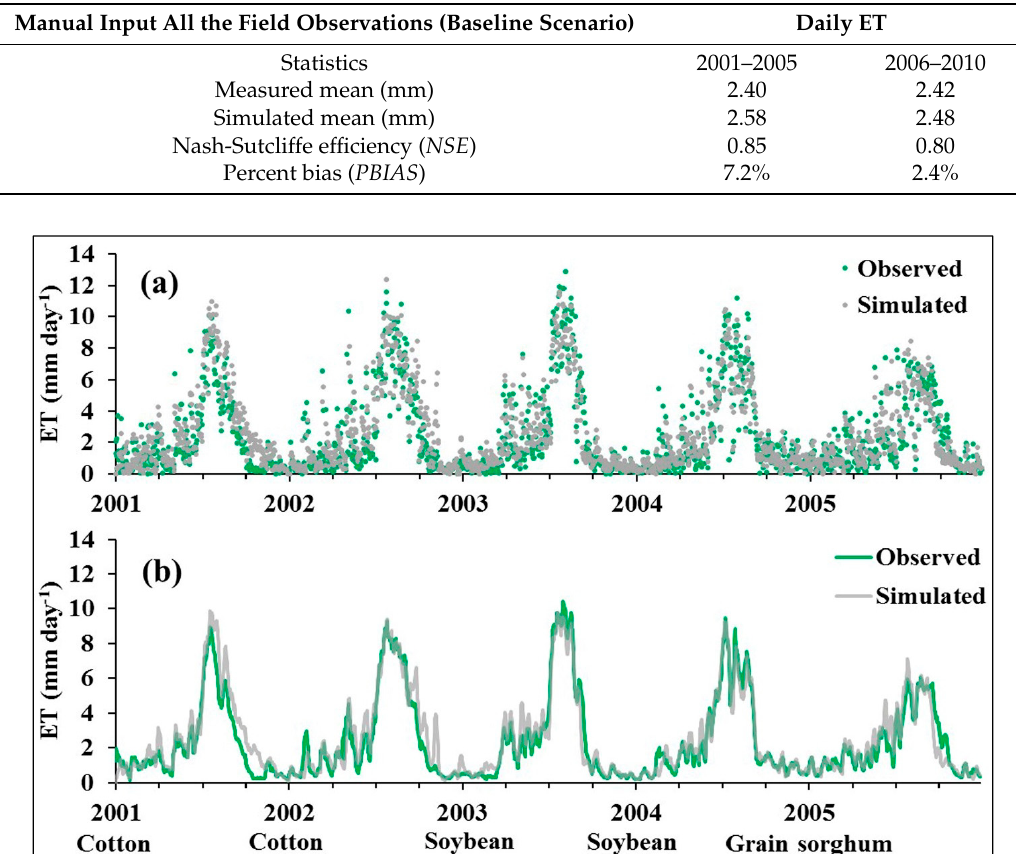
Figure 2. SWAT simulated daily ( a ) and seven-day running average ( b ) Evapotranspiration (ET) versus observed ET of the irrigated lysimeter field during the calibration period (2001–2005).